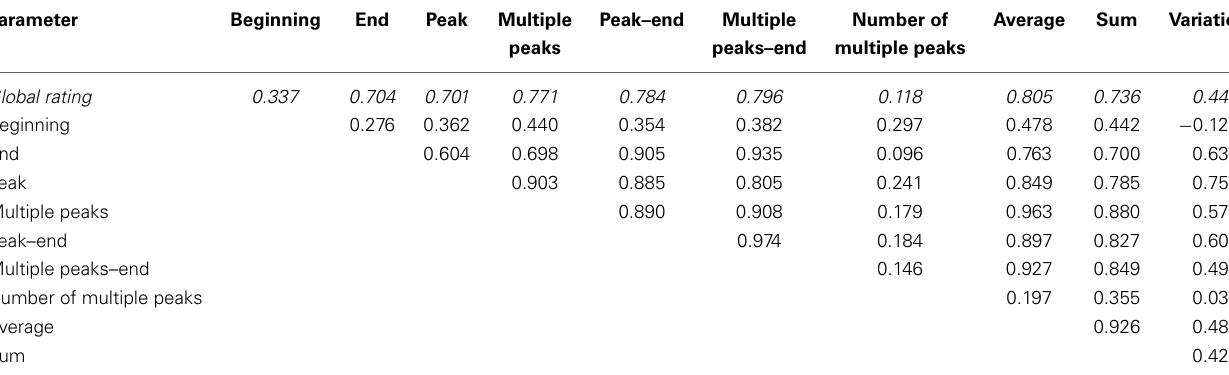
Table 2 | Pearson correlations between the overall evaluation and all the parameters of moment-to-moment experience ( N = 507). Parameter